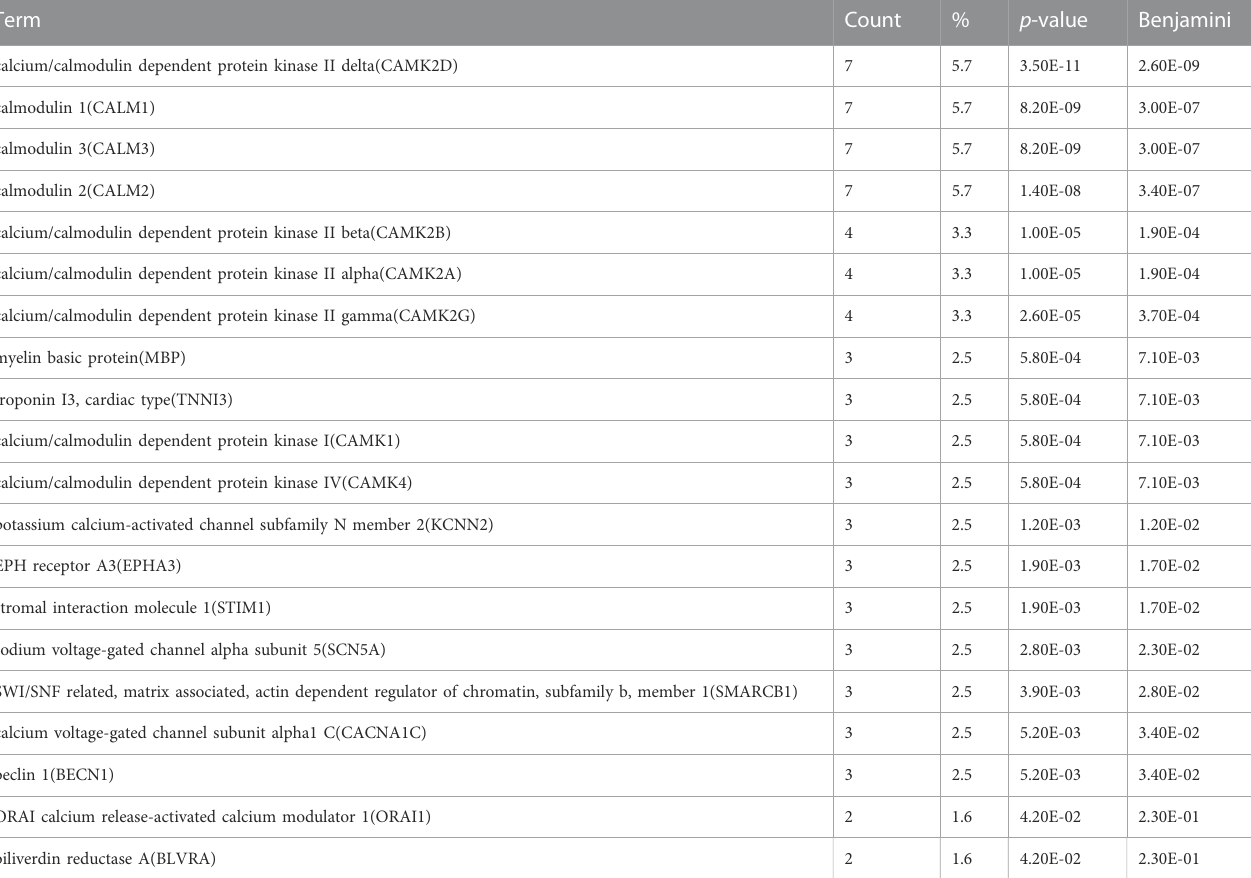
TABLE 5 Enriched Interacting Proteins – Shrew Emesis Genes. Enrichment interacting proteins analysis performed on the set of 125 shrew ( Cryptotis parva ) candidate genes for emesis. Term corresponds to the speci fi c enriched interacting protein, count indicates how many genes within the 125 candidate gene set contained the interactingproteinannotation,%isthepercentofgenescontainingtheannotationwithintheemesiscandidategeneset, p -valueistheuncorrected p -value,Benjamini corresponds to the false discovery rate associated with type I errors in null hypothesis in cases of multiple